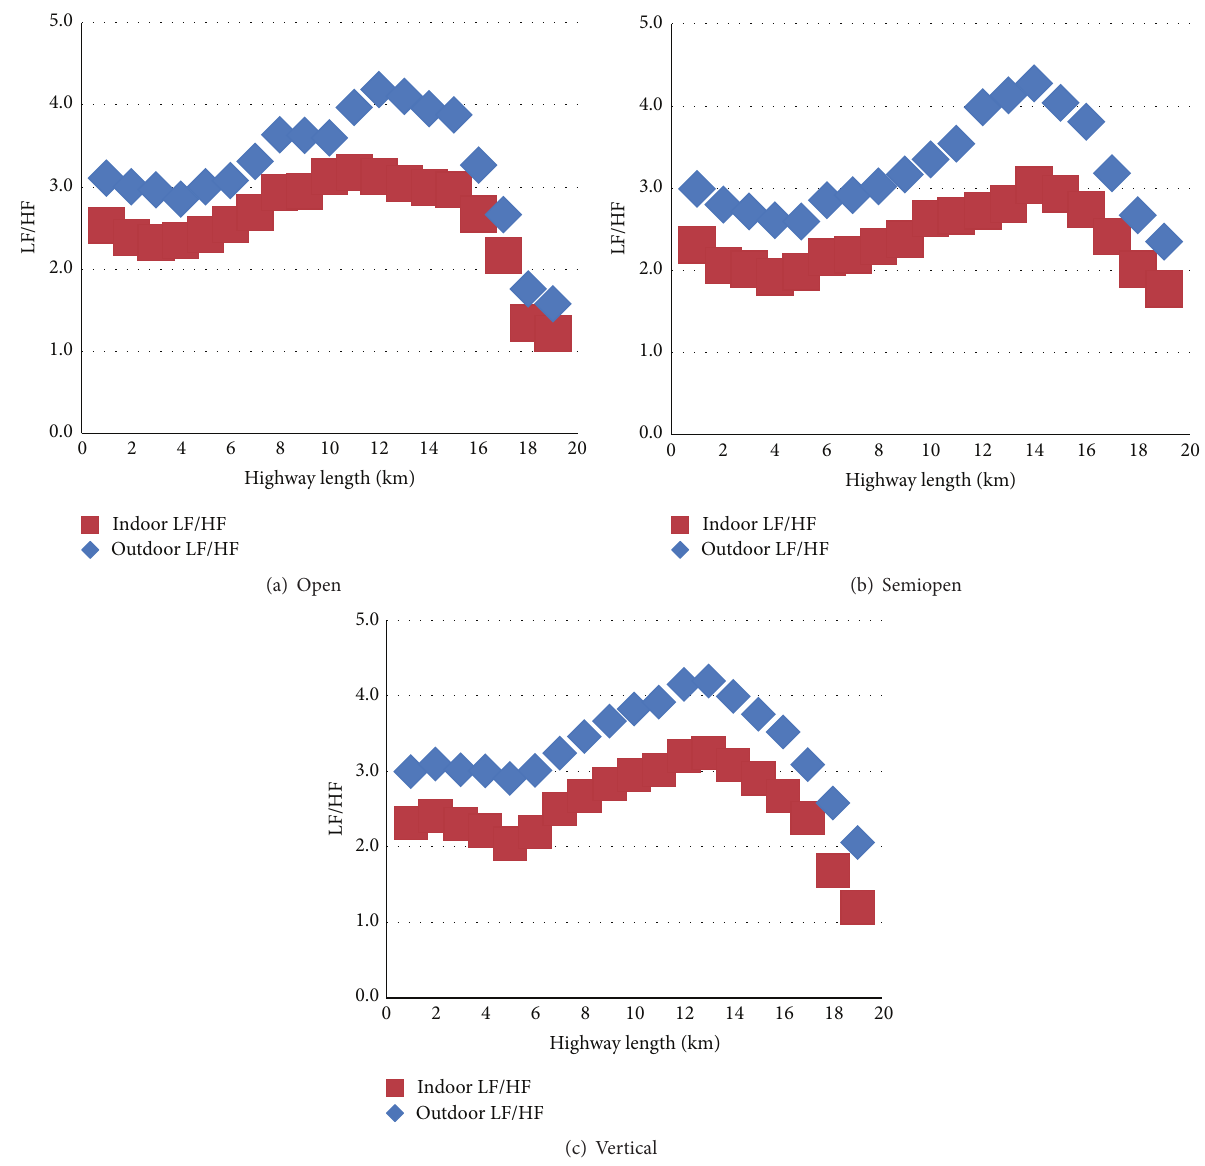
Figure 10: Scatter distribution of LF/HF in the real and simulated vertical